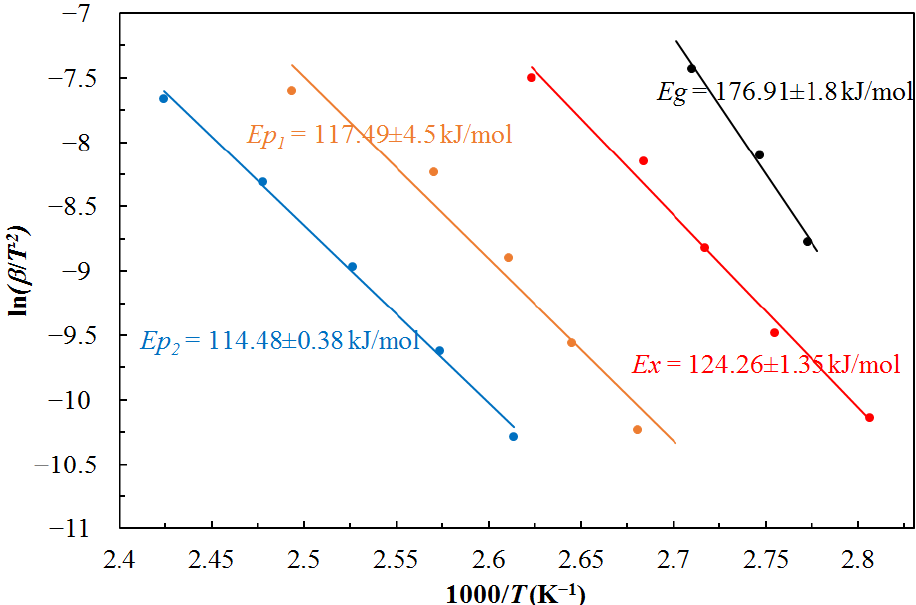
Figure 5. Activation energies for glass transition, crystallization start, and crystallization peak were calculated using the Kissinger method.